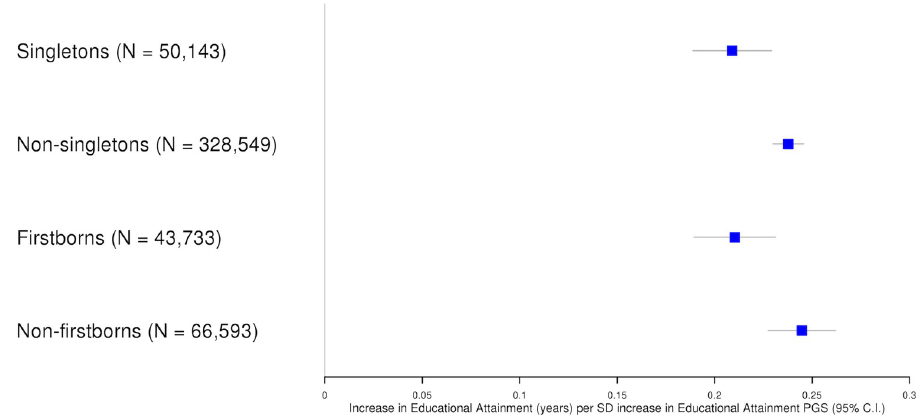
firstborns and non-firstborns.